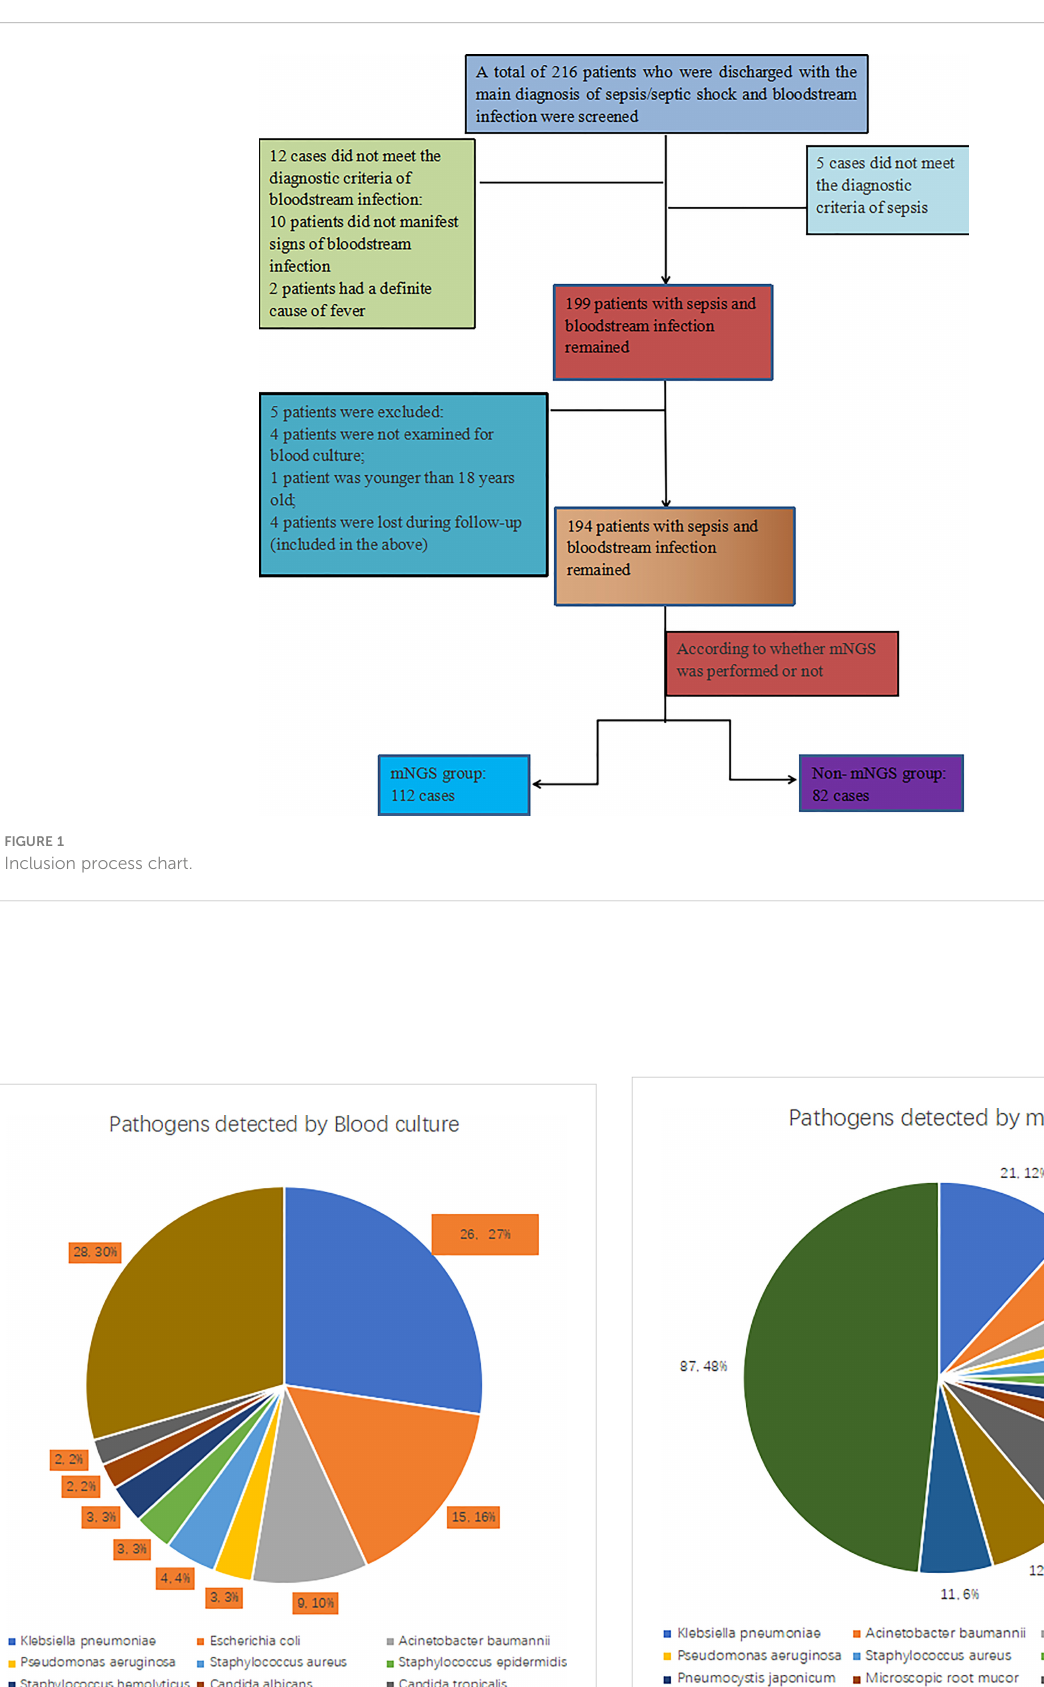
FIGURE 3 Pathogens detected by mNGS.